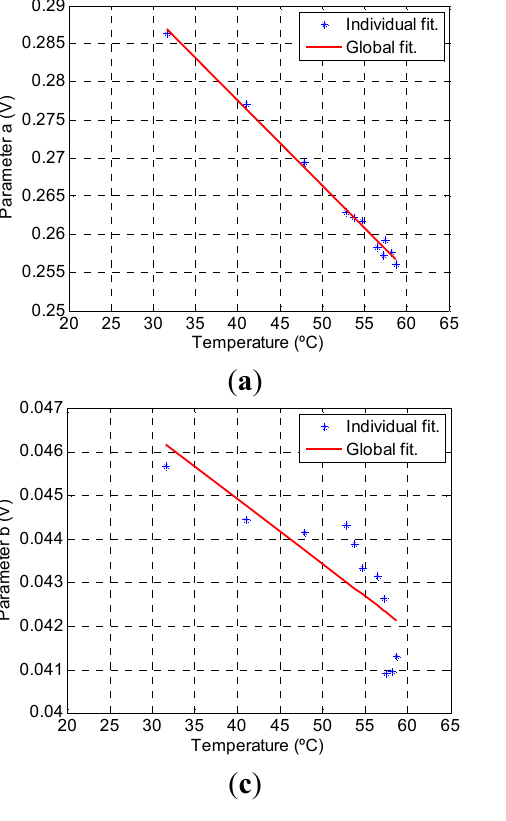
Individual fit. Global fit.